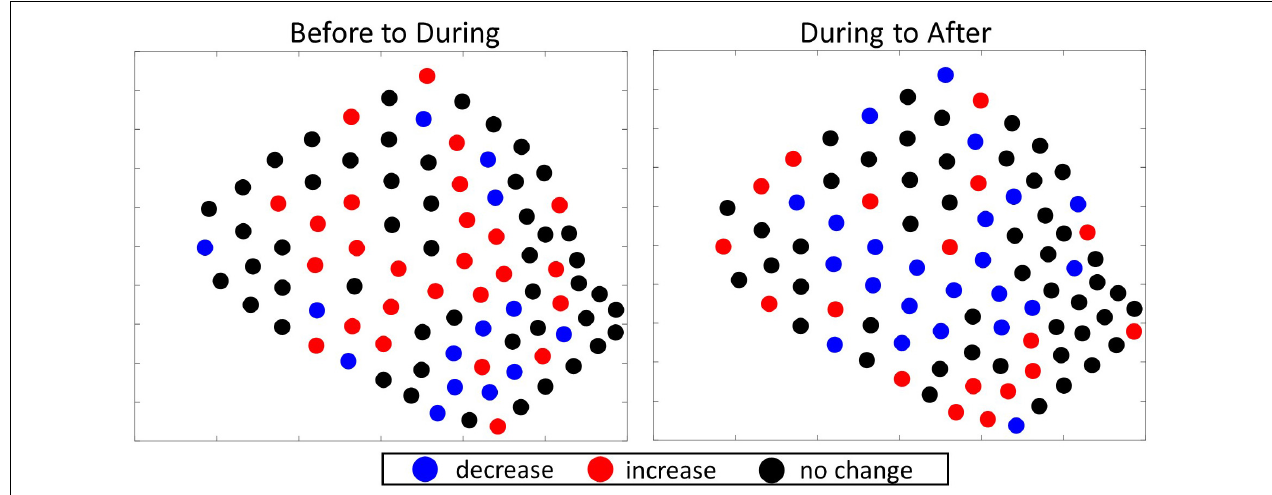
FIGURE 7 | Difference plots showing the direction of change in the number of GVPs per hydrophone from one period to the next of the 2019 survey. Left : difference plot showing change from Before to During ; Right : difference plot showing change from During to After